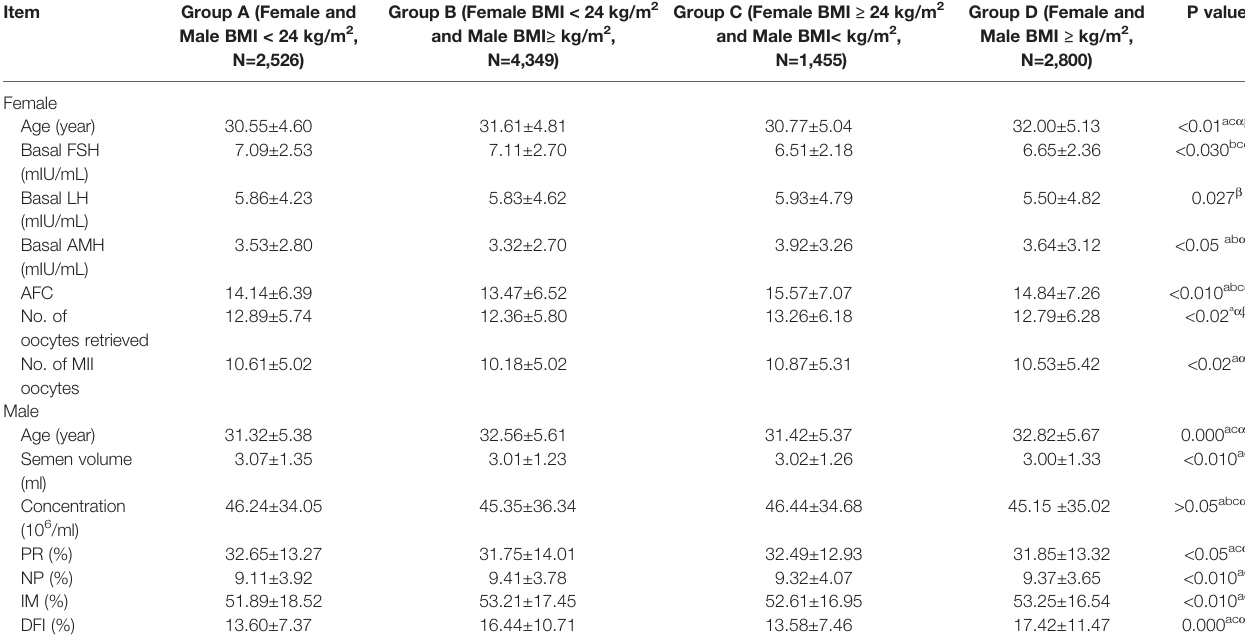
BMI,Bodymassindex;FSH,folliclestimulatinghormone;LH,luteinizingHormone;AMH,Anti-Müllerianhormone;AFC,AntralFollicleCount;PR,Progressivemotility;NP,Non-progressive motility; IM, In-motility; DFI, Sperm DNA fragmentation index. P < 0.05 was considered to be statistically signi fi cant. a Group A vs Group B. b Group A vs Group C. c Group A vs Group D. a Group B vs Group C. b Group B vs Group D. g Group C vs Group